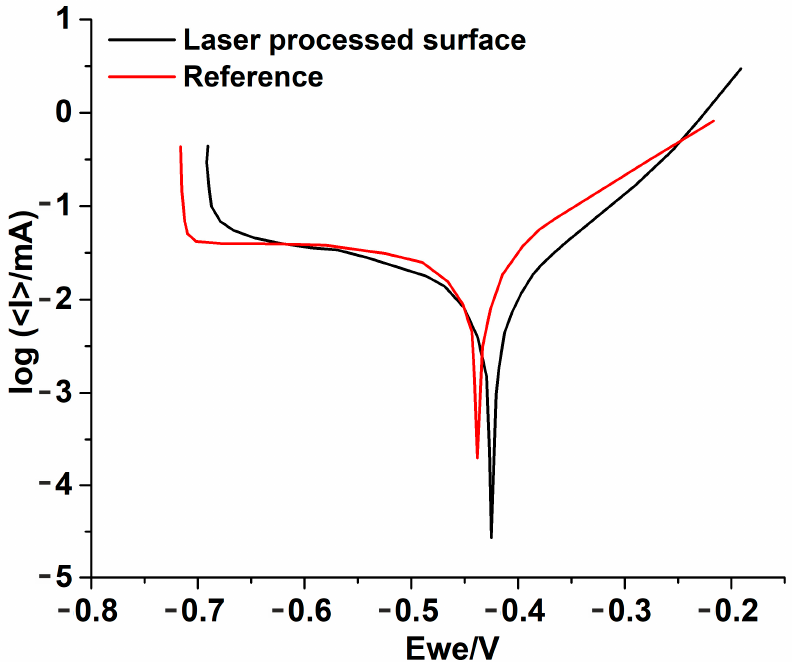
Figure 11. Polarization curves of the reference surface and of the laser processed surface.